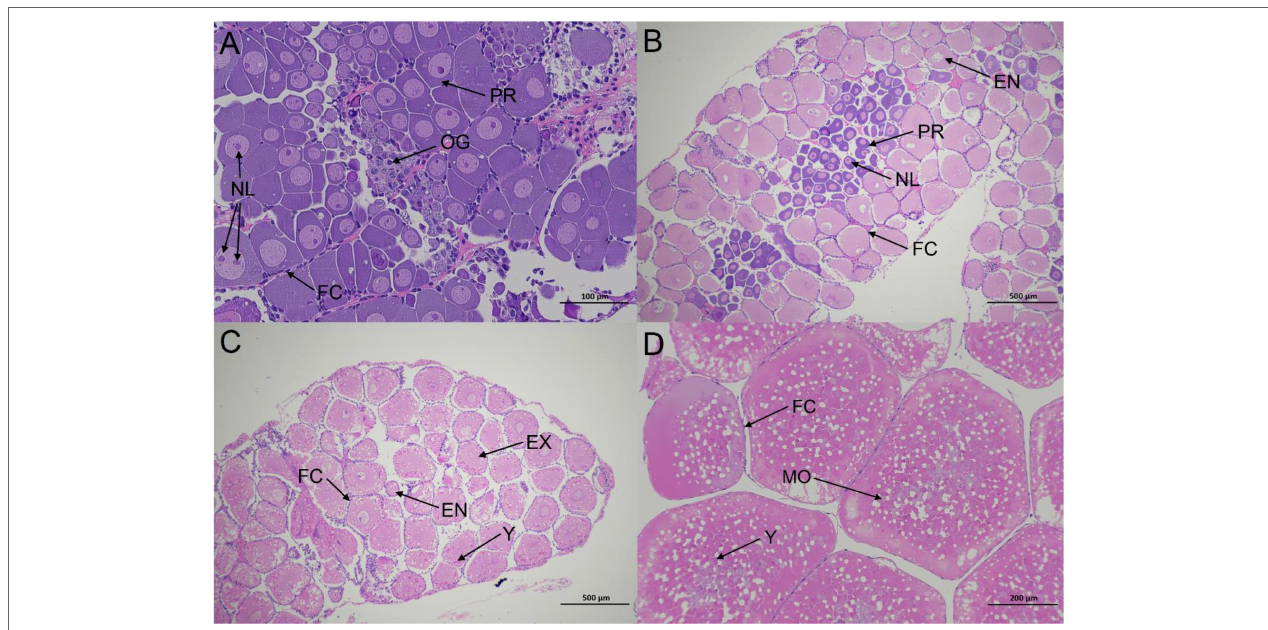
FIGURE 1 | Histological sections illustrating the ovarian status at different stages in E. carinicauda (A) proliferative phase (Stage I), ×200. (B) minor growth phase (Stage II), ×40. (C) major growth phase (Stage III), ×40. (D) mature phase (Stage IV), ×100. EN, endogenous vitellogenic oocytes. EX, exogenous vitellogenic oocytes. FC, follicle cell; MO, mature oocytes; NL, nucleolus; OG, oogonium; PR, previtellogenic oocytes; Y, yolk